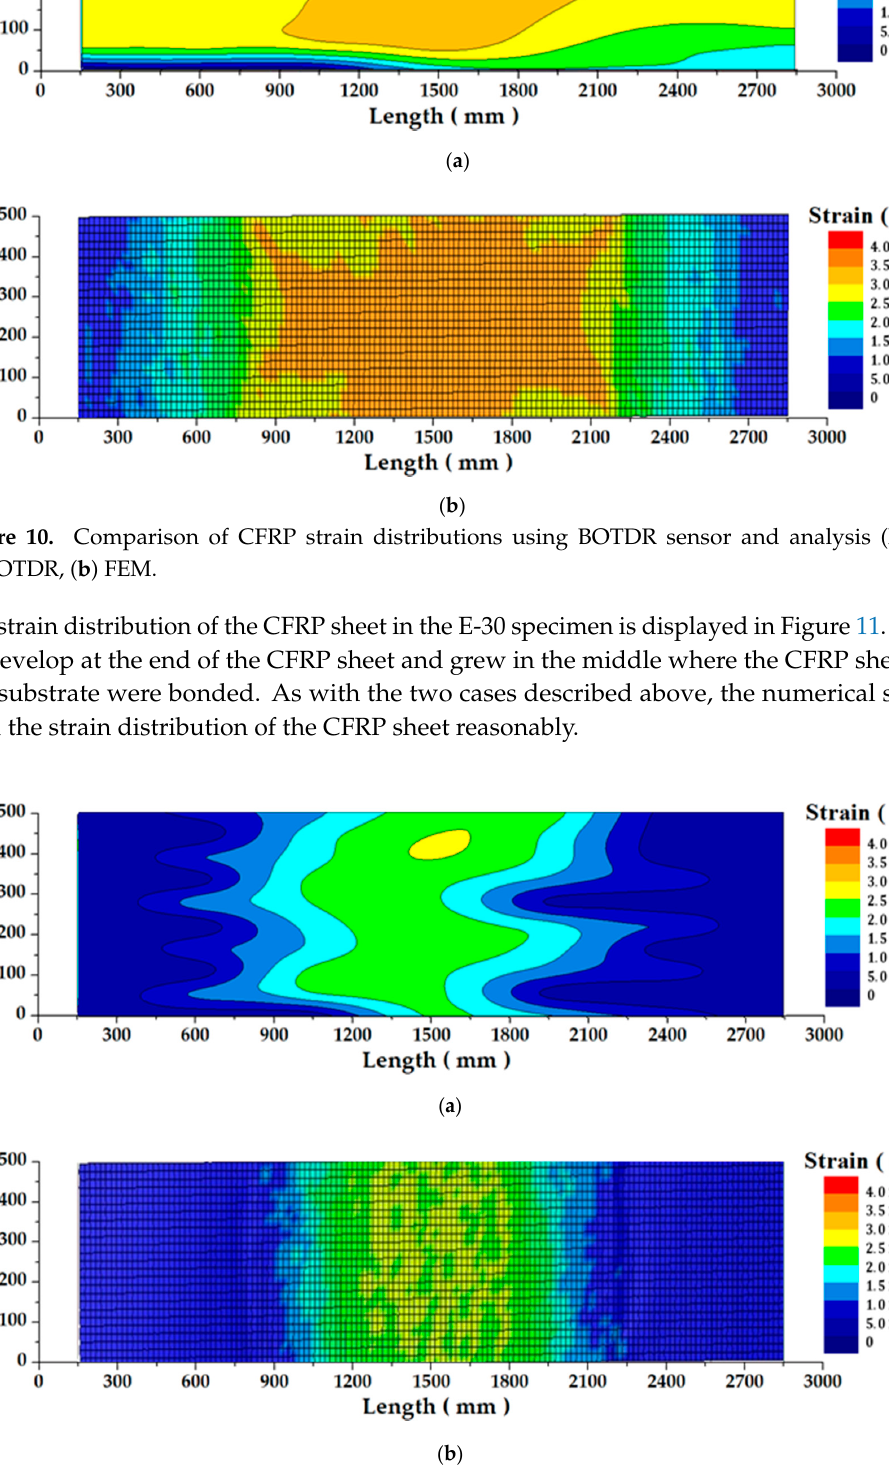
Figure11. ComparisonofCFRPstraindistributionsusingBOTDRsensorandanalysis(E-50). ( a )BOTDR, Figure 11. Comparison of CFRP strain distributions using BOTDR sensor and analysis (E-50). ( a ) ( b ) BOTDR, ( b ) FEM.